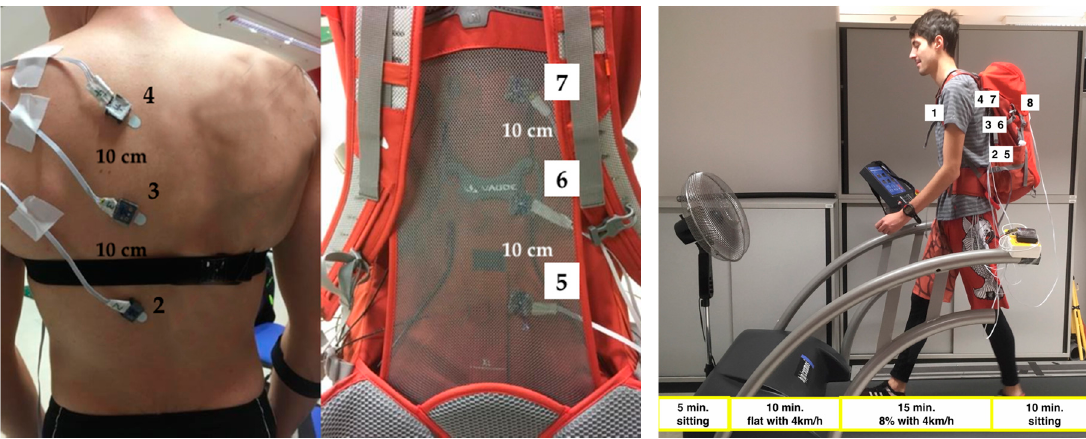
Figure 2. ( Left ): Sensor application on the upper back (4), middle back (3) and lower back (2). ( Middle ): Sensor application on the backpack. ( Right ): Whole measurement